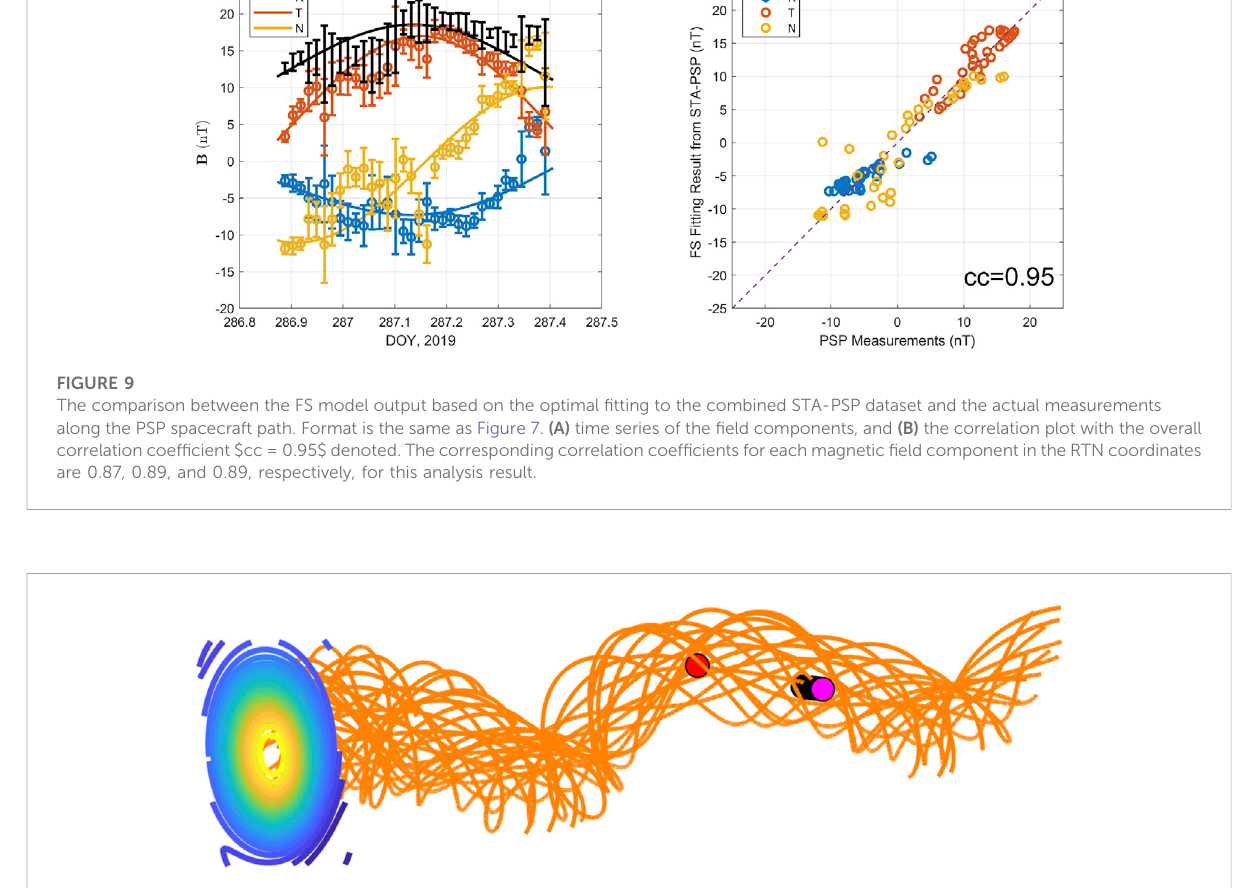
FIGURE 10 The corresponding fi eld line con fi guration for the STA-PSP optimal fi tting result in a 3D view along the STA path toward the Sun. Format is the same as Figure 6. Note here there exists only one major positive B z polarity on the bottom plane shown to the left (east with respect to the